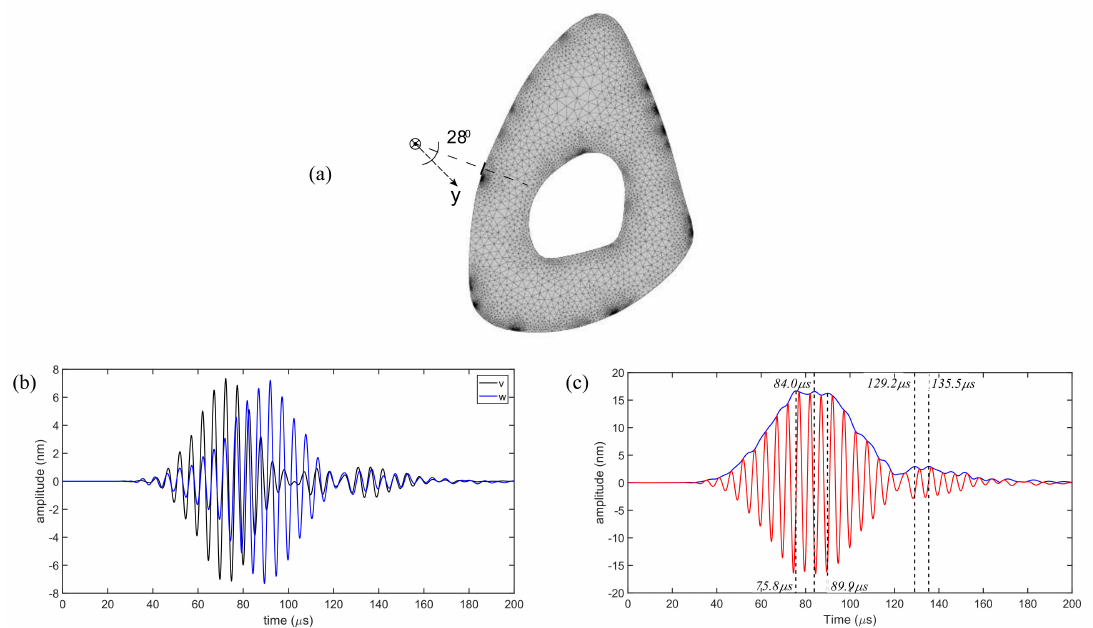
Figure 5. Finite element simulation of wave propagation in a human tibia provided displacement waveforms at the analogous point where LDV measurements were made on the synthetic bone. ( a ) Relative position of normal at the reception region, ( b ) the displacement components v and w , and ( c ) the displacement component normal to the surface and the Hilbert envelope used to identify peaks.